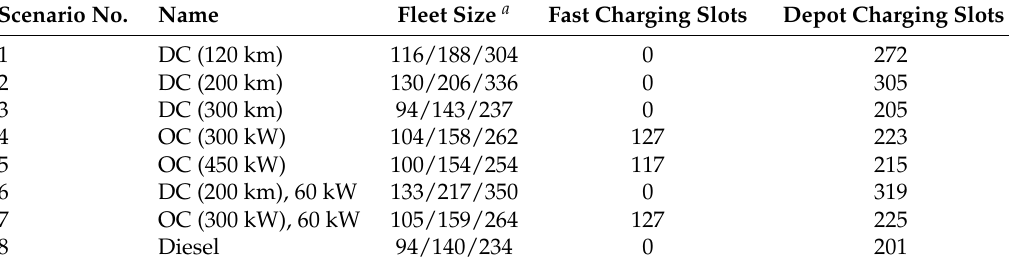
Table 7. Simulation results for fully electric scenarios and diesel reference